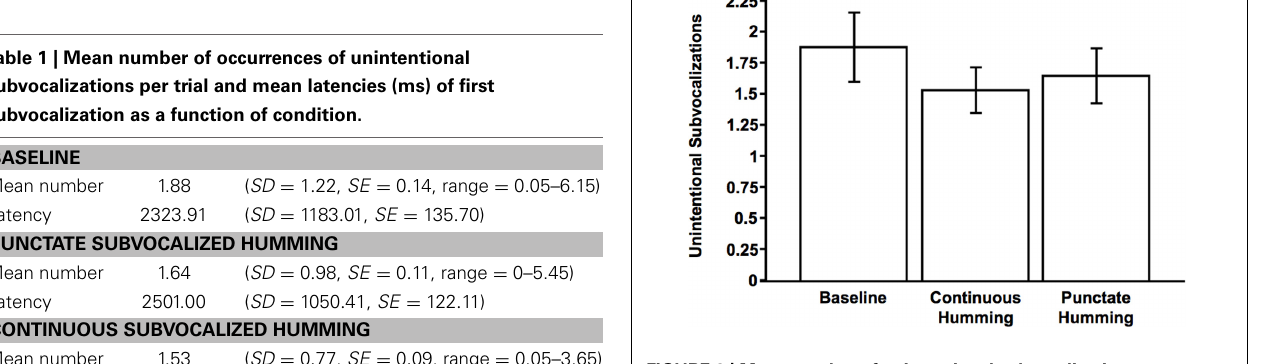
FIGURE 2 | Mean number of unintentional subvocalizations as a function of condition (Baseline, Continuous Hum, Punctate Hum). Error bars indicate 95% confidence